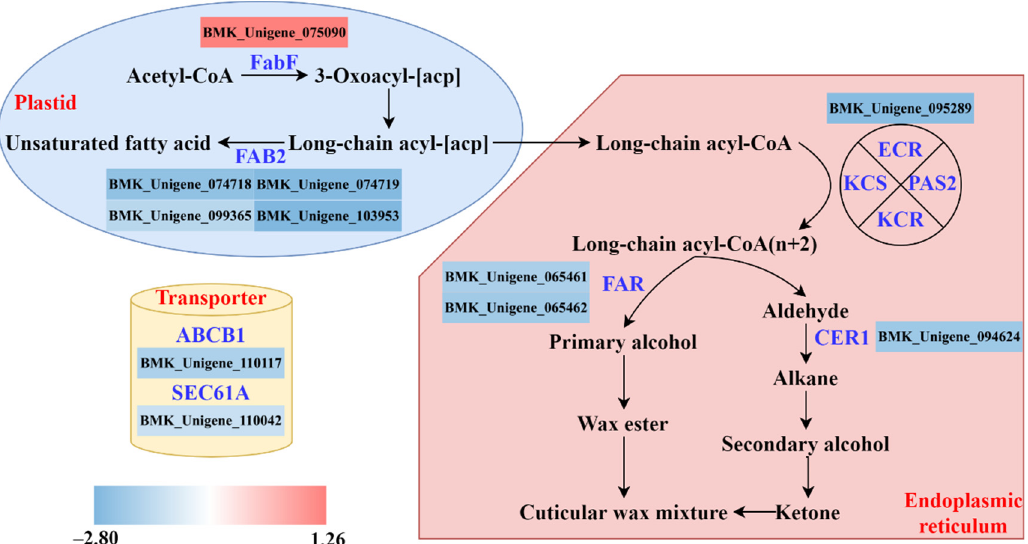
Figure 6. Proposed model for cuticular wax biosynthesis. Color bars ranging from blue to red represent downregulation and upregulation in transcript expression. Gene ID is shown.